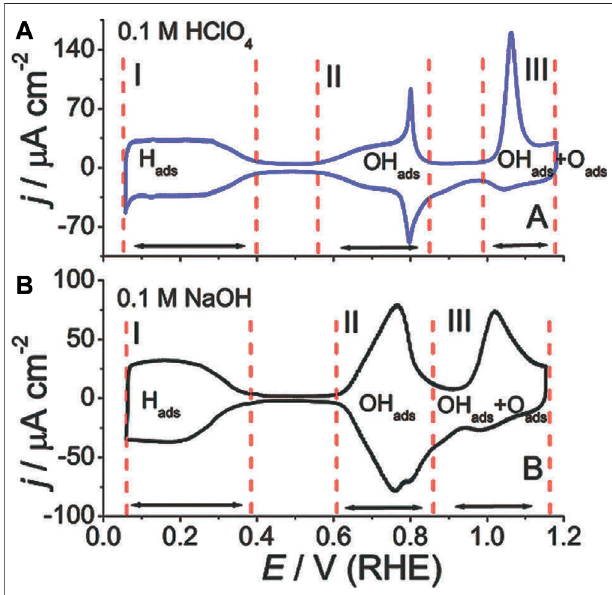
FIGURE 5 | (A,B) CV curves of single crystalline Pt in different electrolytes. Reproduced with permission (Gómez-Marín et al., 2014). Copyright 2014, Royal Society of